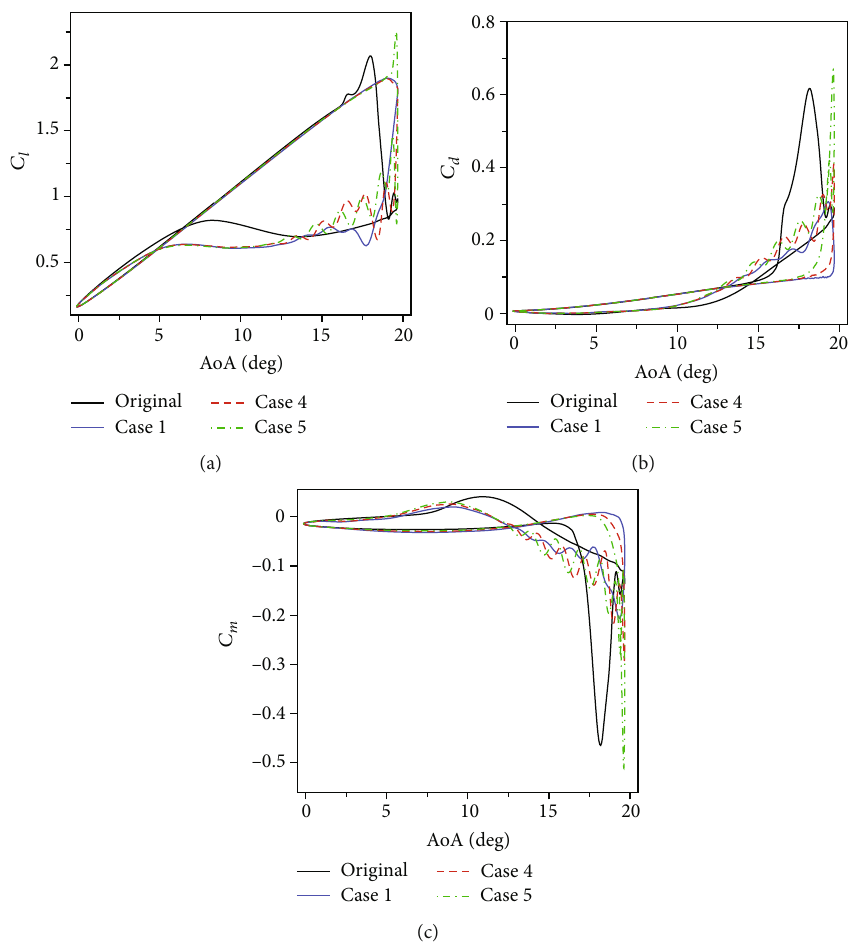
Figure 24: Comparison of aerodynamic coe ffi cients for Cases 1, 4, and 5: (a) lift coe ffi cients, (b) drag coe ffi cients, and (c) pitching moment coe ffi